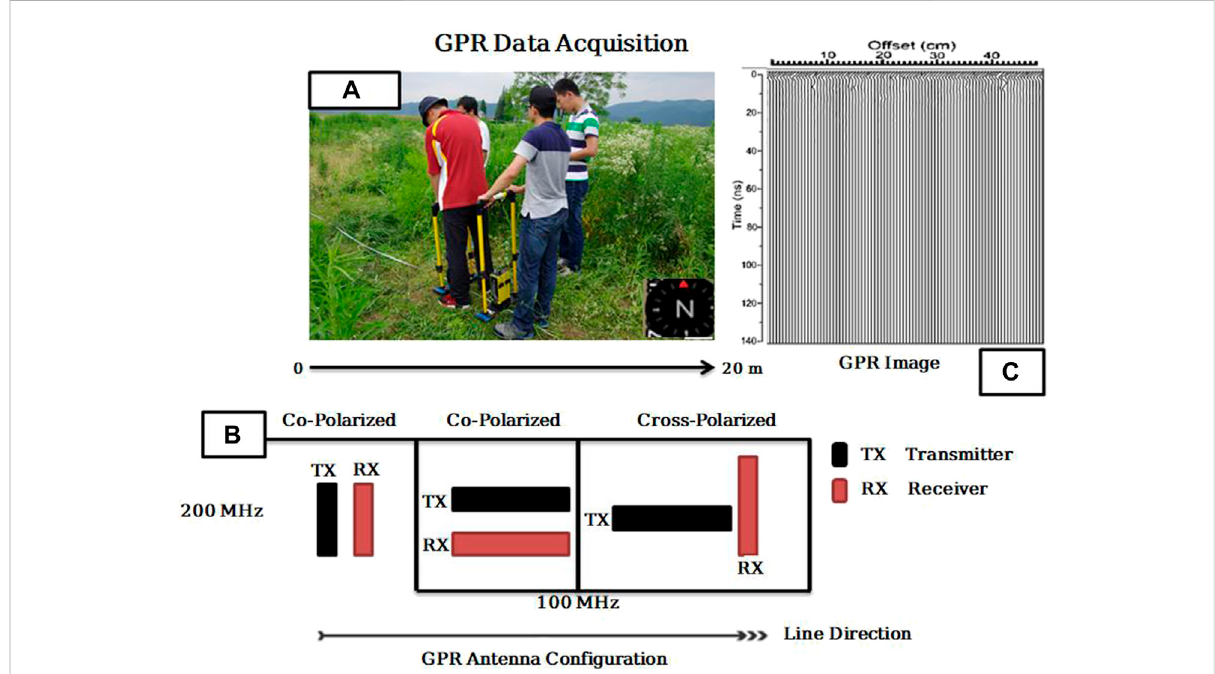
FIGURE 2 (A) GPRsurveywith100 – 200 MHzantennas; (B) Antennacon fi gurations usedintheGPRstudyonthearchaeologicaltestsite.Thetransmitting and receiving antennas are represented by black and red blocks, respectively. The antenna offsets for the 200 and 100 MHz bands are 0.5 and 1 m, respectively; (C) topography GPR